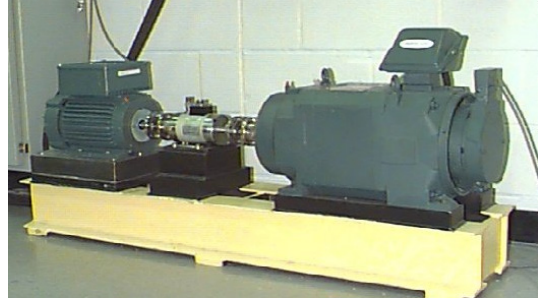
Figure 10. Rolling bearing testbed.